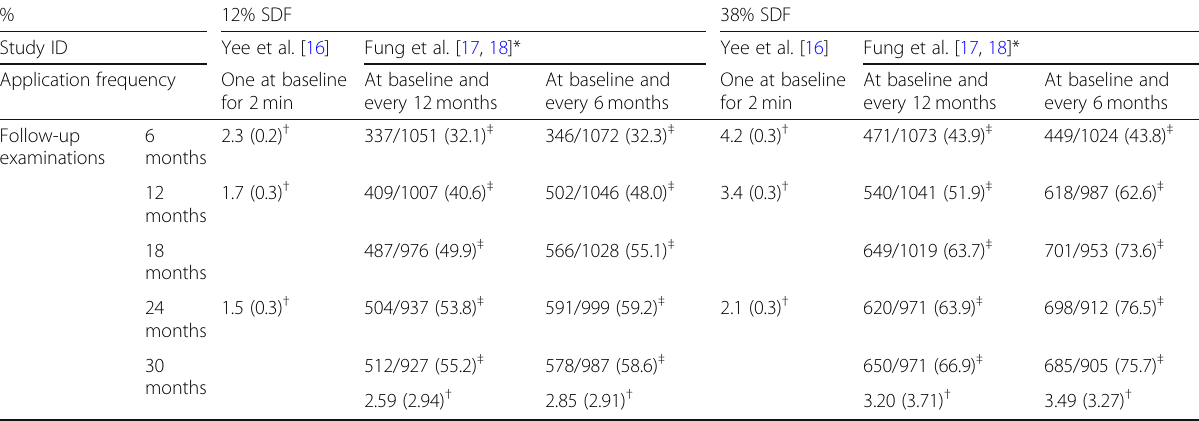
Table 2 Caries arrestment — 12% SDF versus 38%